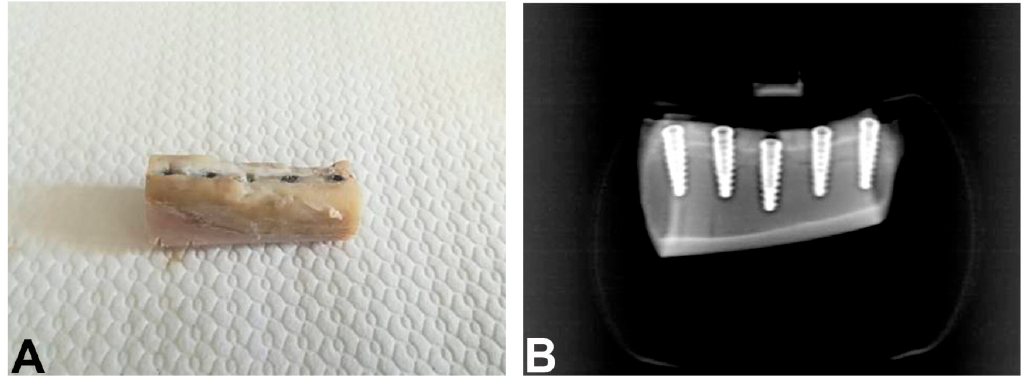
Figure 2. Block section of tibia ( A ). Rx of the implants inserted in tibia after 1 month of healing ( B ).